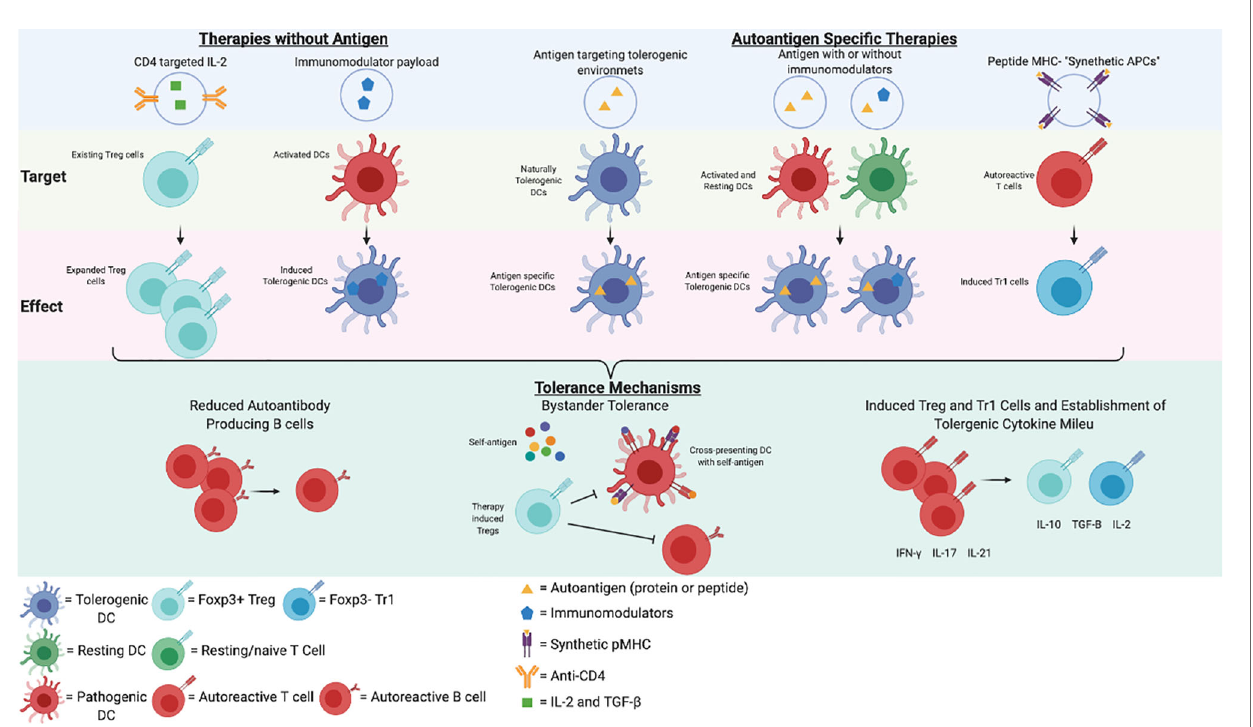
FIGURE 1 | Potential Nanoparticle Therapies in SLE. A representation of potential immunotherapies for SLE and a simpli fi ed schematic of their mechanisms of action. This fi gure was created in